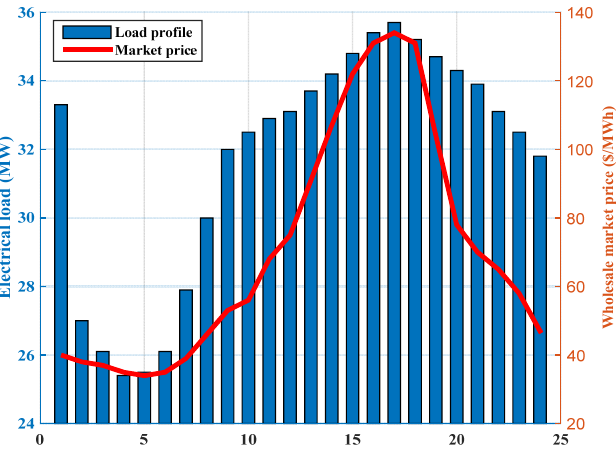
Figure 6. Measured electrical load and real wholesale electricity market prices [32].